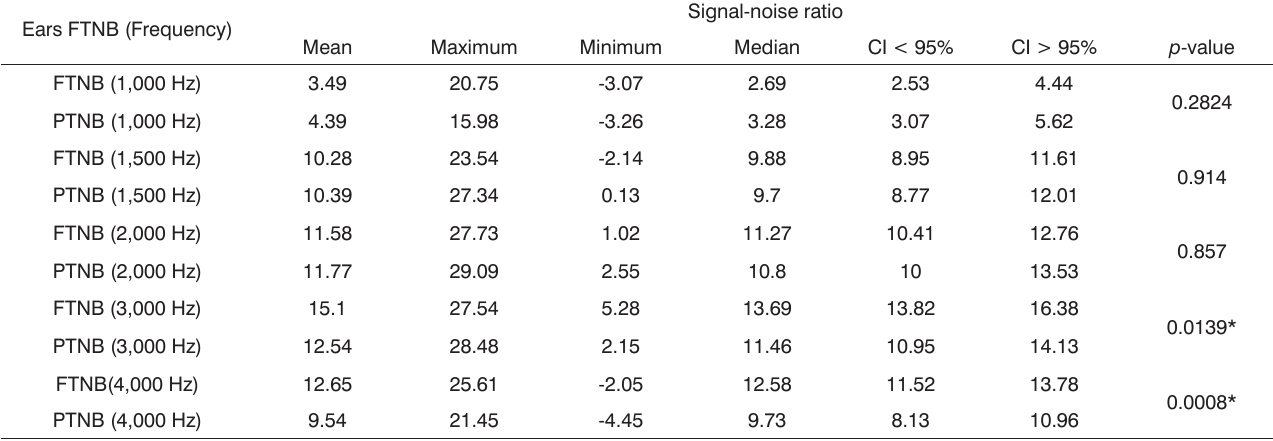
Table 3. Comparison of the signal-noise ratio variable of TEOAEs (in dB SPL), for each frequency band, found in full term and preterm babies, in both